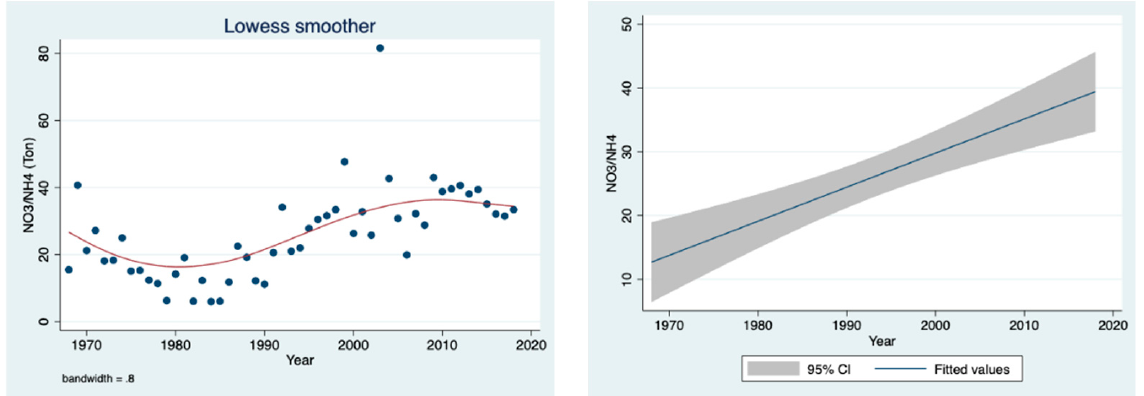
Figure 10. Linear prediction (95% CI) ( left ) and LOWESS smoother (0.8 bandwidth) trend of changes ( right ) between annual means of mass (ton) ratio and between nitrate and ammonium in River Jordan water (Huri Station) and years (1968–2018).